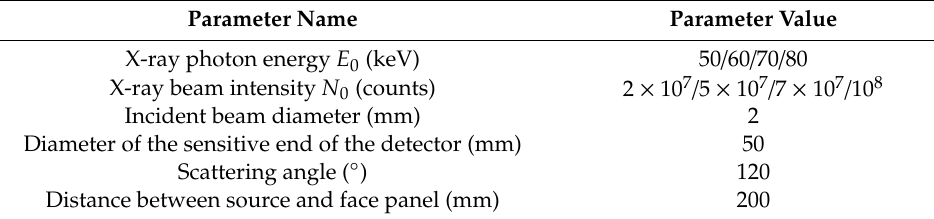
Table 3. The primary process parameters of the detection